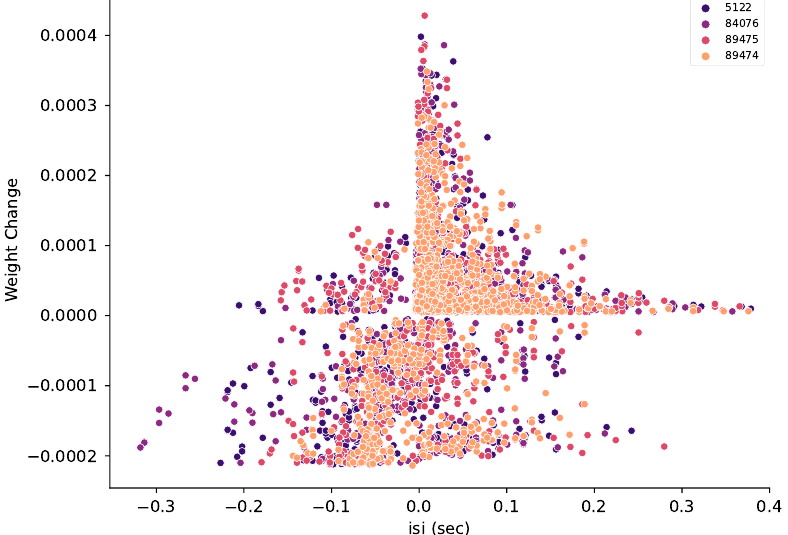
Figure A5. Instantaneous synaptic weight as a function of interspike interval. Interspike interval is calculated as time of post-synaptic spike minus time of pre-synaptic spike for the pair of spikes closest in time and prior to the weight change. Small positive ISIs are more likely to produce LTP, and negative ISI are more likely to produce LTD, though the weight change is quite variable. Results are shown for four different